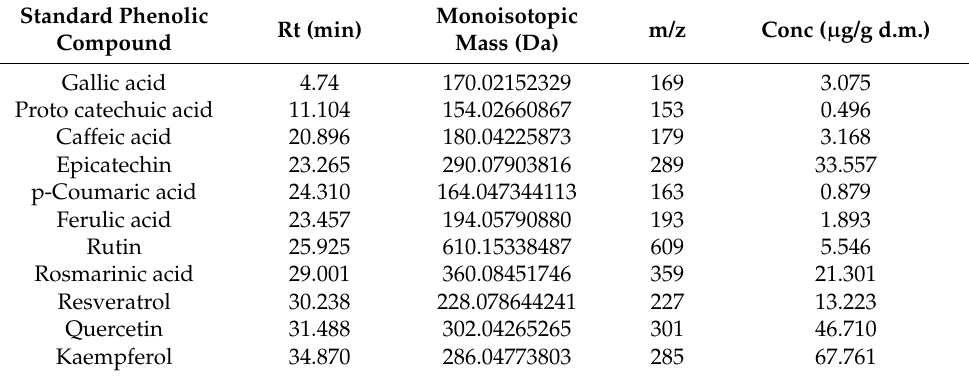
Table 1. Individual phenolic compounds quantification by LC-MS in Helleborus purpurescens extract.